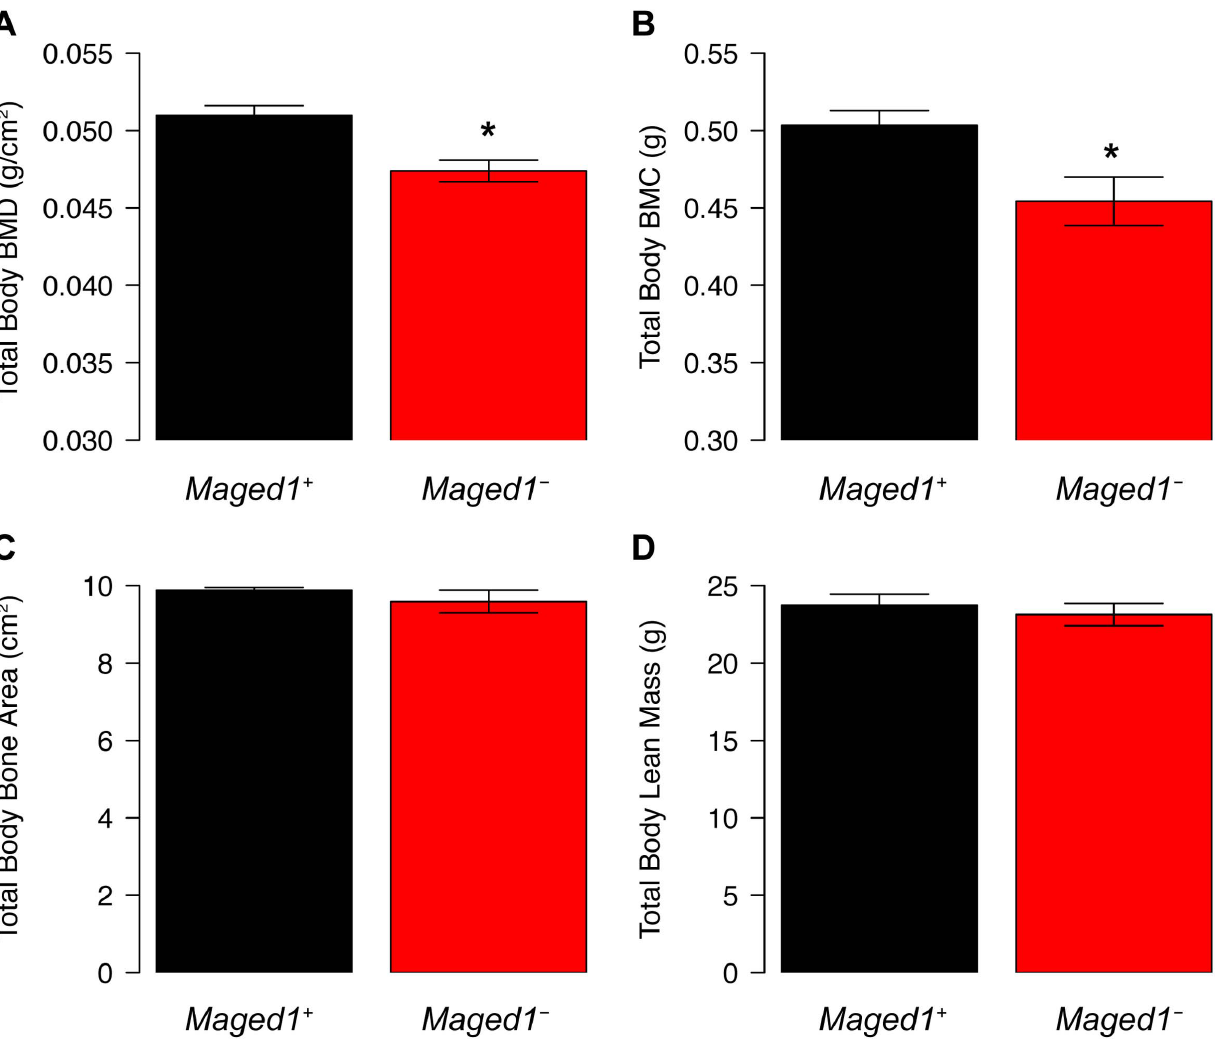
Figure 5. BMD is decreased in Maged1 -deificient mice. (A) BMD and (B) BMC is decreased in Maged1 2 mice relative to wild-type littermates ( Maged1 + ). There is no difference in (C) bone area or (D) lean mass between genotypes. *P ,